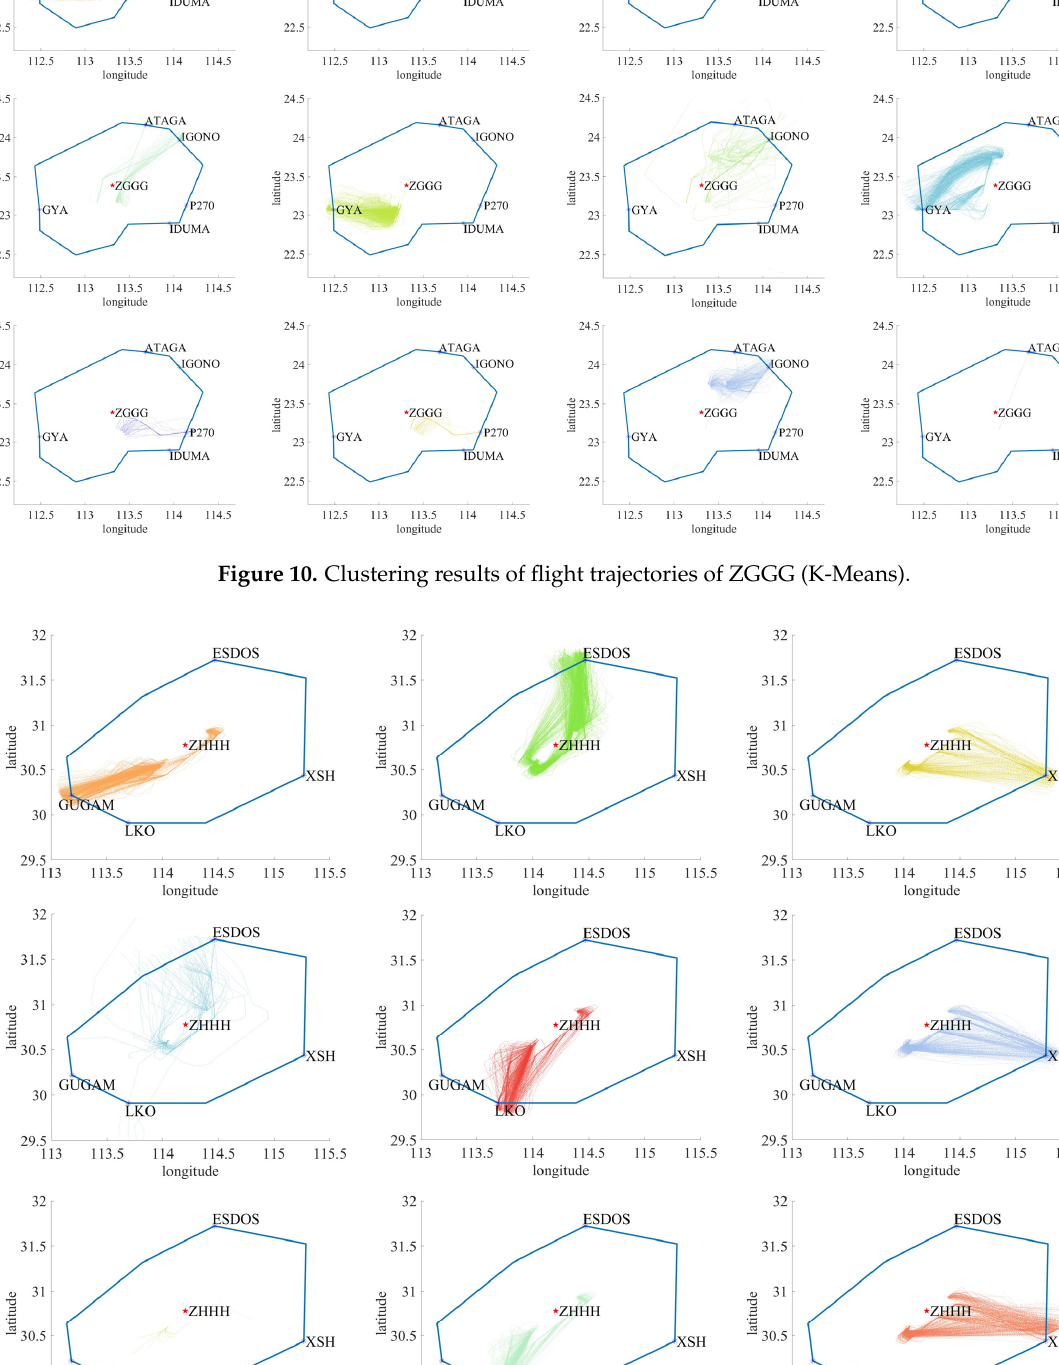
Figure 12. Clustering results of flight trajectories of ZGGG (DBSCAN).